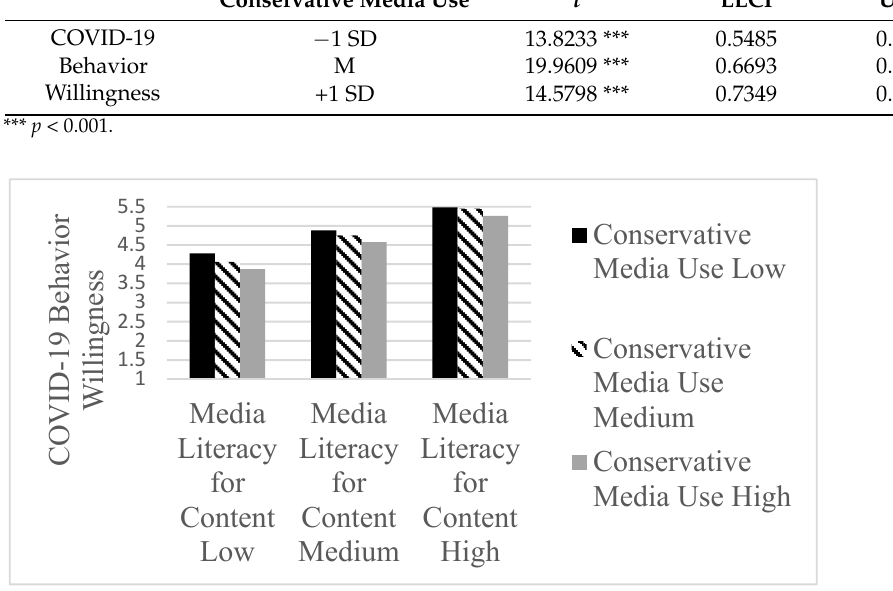
Figure 3. Interaction effects between Conservative Media use and Media Literacy for Content on COVID-19 Behavior Willingness.